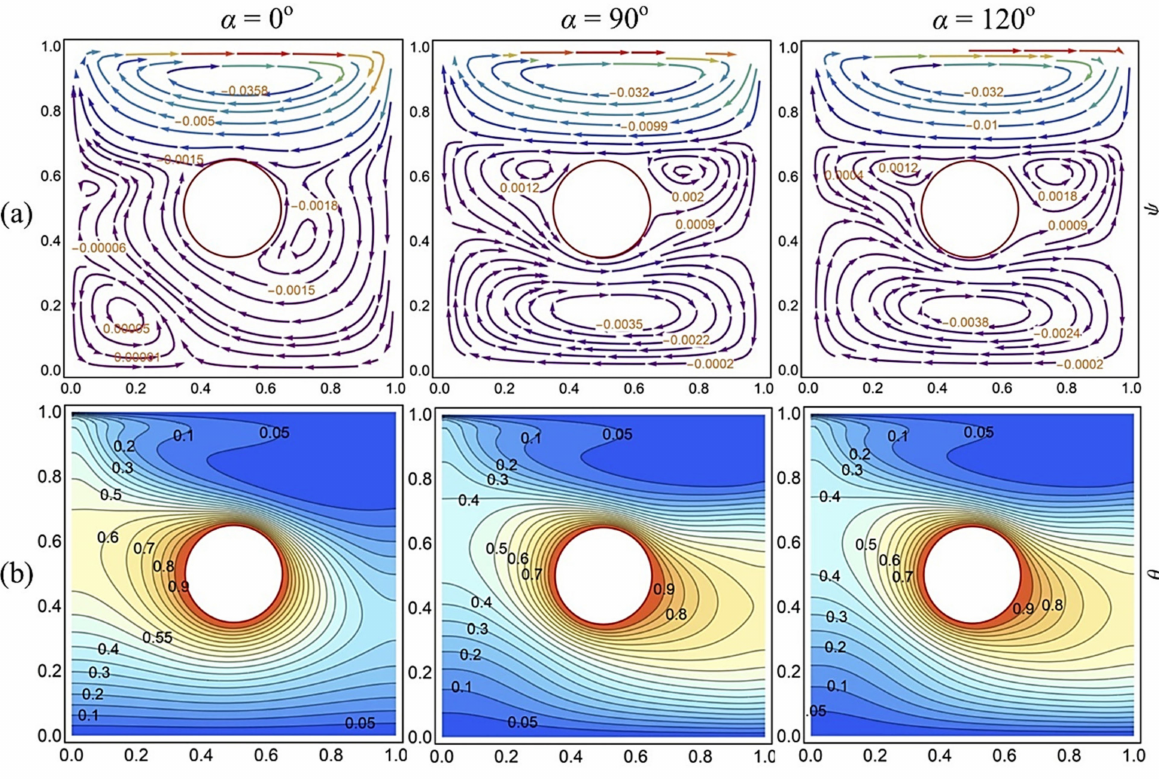
Figure 6. ( a ) Streamlines ( b ) Isotherms for different angle of inclination α while the other parameters φ hnf = 0.02, Ha = 50, Ri = 1, Re = 100, r = 0.15 and β = 0 ◦ are kept